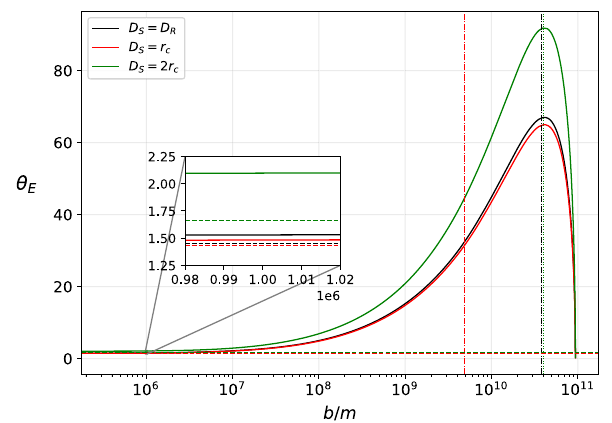
Fig. 9 The angular radius of the Einstein ring for URC profile in Sgr. A*